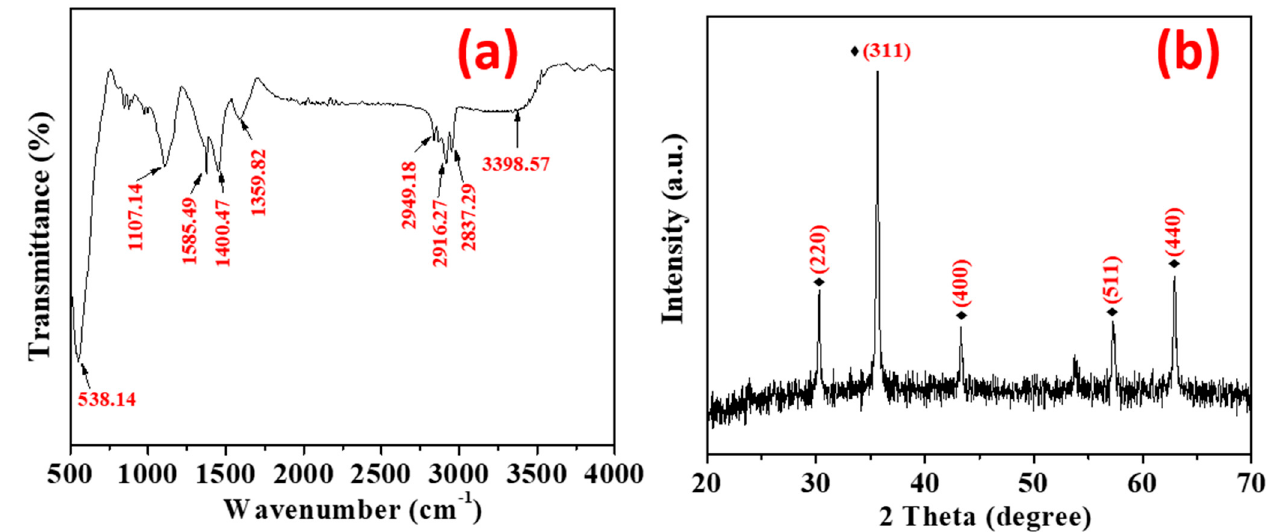
Figure 1. ( a ) FT ‐ IR spectra of Fe 3 O 4 NPs, ( b ) XRD patterns of Fe 3 O 4 NPs. Figure 1. ( a ) FT-IR spectra of Fe 3 O 4 NPs, ( b ) XRD patterns of Fe 3 O 4 NPs.